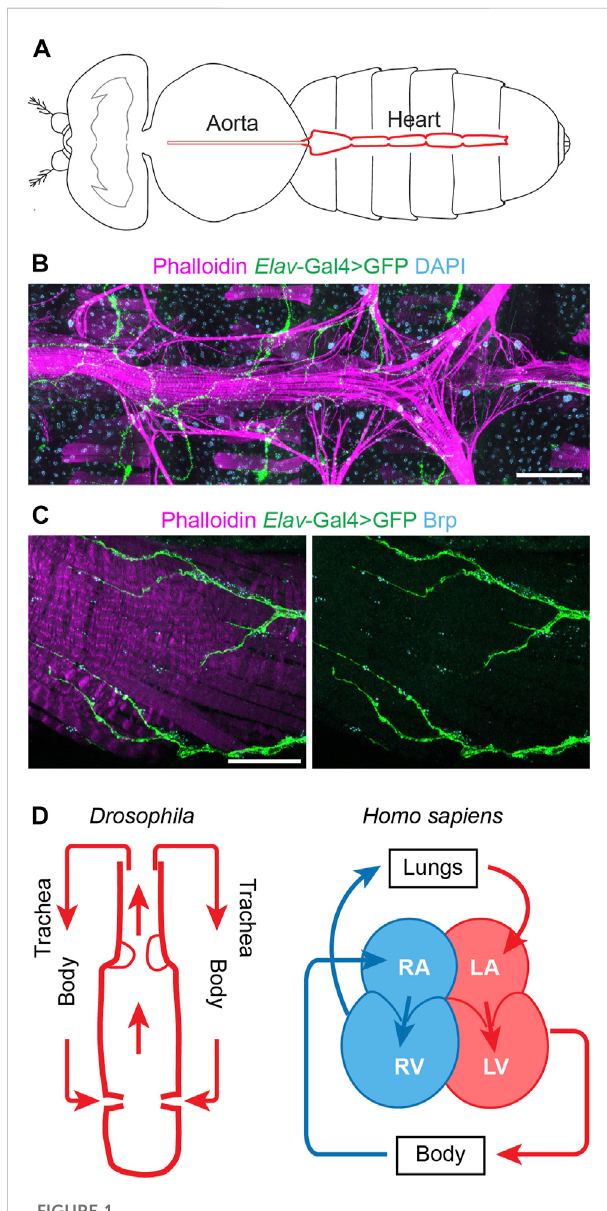
FIGURE 1 The Drosophila andhumanhearts. (A) Schematicillustrationofanadult fl y(dorsalview).Theaortaandtheheartareshowninred. (B) Representative image of a Drosophila adult heart (ventral view). Phalloidin stains fi lament actin in red. The elav -Gal4 > GFP ( elav, embryonic legal abnormal vision ; GFP, green fl uorescent protein) labels cardiac neuron fi ber in green. DAPI stains DNA in blue. The scale bar represents 100 μ m. Image was obtained using a ZEISS Apotome fl uorescence microscope using a 20× objective and ZEISS Zen (blue edition) acquisition software. (C) Representative image of the posterior Drosophila adult heart (ventral view). Phalloidin stains fi lament actin in red. The elav -Gal4 > GFP ( elav, embryonic legal abnormal vision ; GFP, green fl uorescent protein) labels cardiac neuronal axons in green. Brp, Bruchpilot, is in blue and labels the neuromuscular junctions. The scale bar represents 20 μ m. Images were obtainedusingaZEISSLSM900confocalmicroscopeusinga63×objective and ZEISS Zen (blue edition) acquisition software. (D) Schematic representations of the fl y ( Drosophila ) and human ( Homo sapiens ) hearts. Arrows indicate the direction of fl ow for the fl y hemolymph and human blood (blue, oxygen poor; red, oxygen rich blood). Structure inside the fl y heart depicts the aortic valve, and fl ow enters the heart at the in fl ow tracts with ostia (valves). Human heart chambers: RA, right atrium; RV, right ventricle; LA, left atrium; LV, left